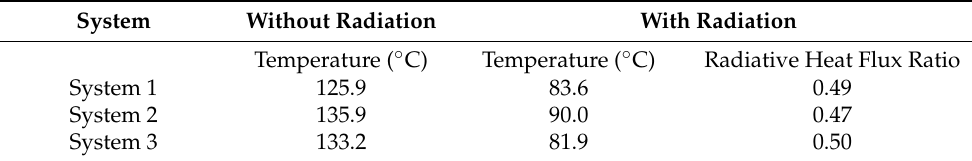
Table 4. System surface-averaged temperature and radiative heat flux for Configuration 1.